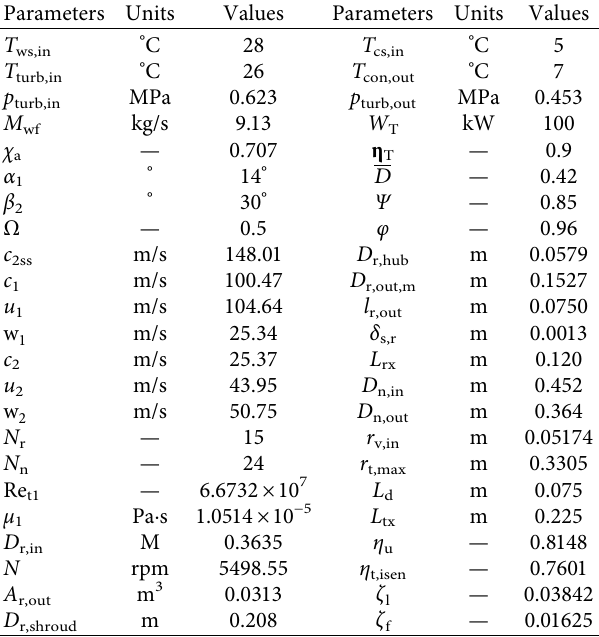
Table 1: Te main parameters and 1-D design results. Parameters Units